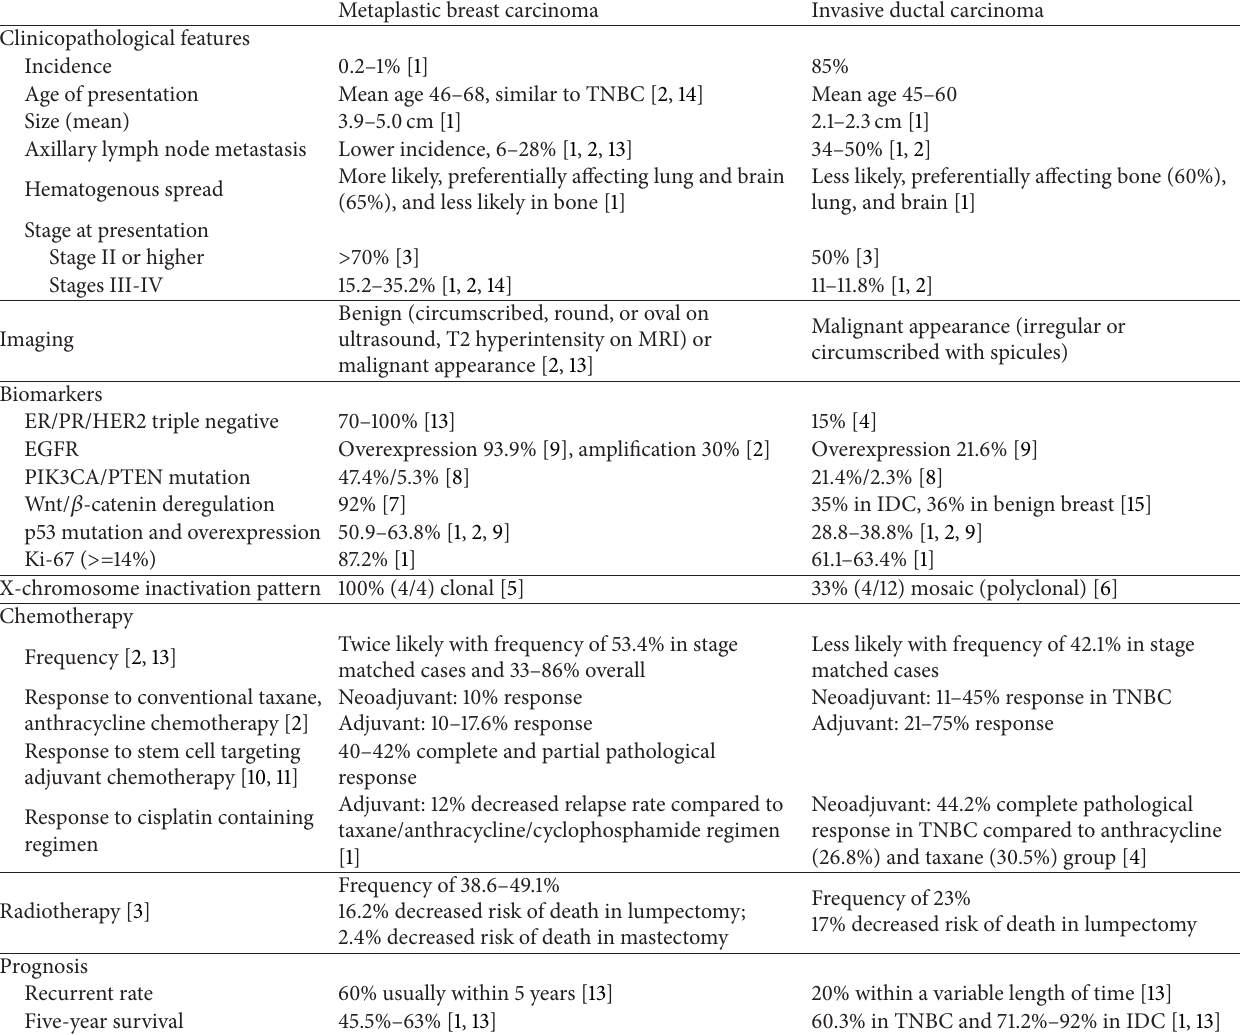
Table 1: Incidence, clinical and image presentation, biology, genetics, chemoradiation therapy, and prognosis of metaplastic breast carcinoma and invasive ductal